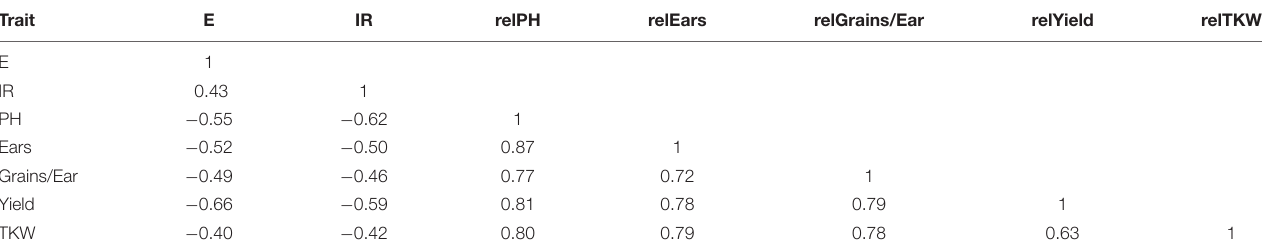
TABLE 2 | Summary of the Pearson correlation matrix for extinction (E), infection rate (IR), relative plant height (relPH), relative number of ears per plant (relEars), relative number of grains per ear (relGrains/Ear), relative grain yield (relYield), and relative thousand kernel weight (relTKW) of 250 wheat accessions tested for WDV resistance. Trait E IR relPH relEars relGrains/Ear relYield relTKW